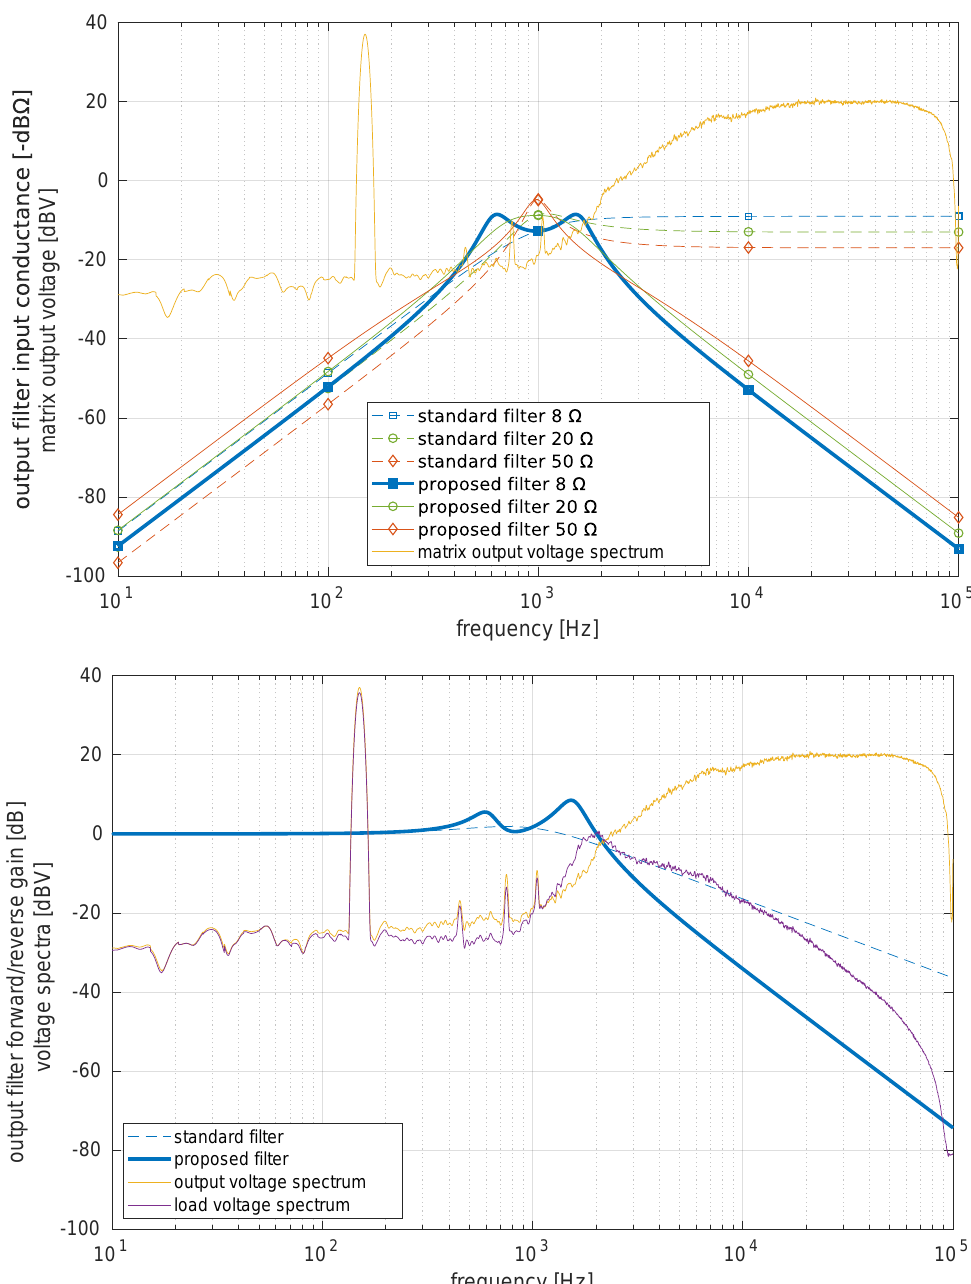
Figure 7. Output filter behavior: input conductance and gain on the top and bottom panel, respectively. Output and load voltage spectrum on the top and bottom panel,